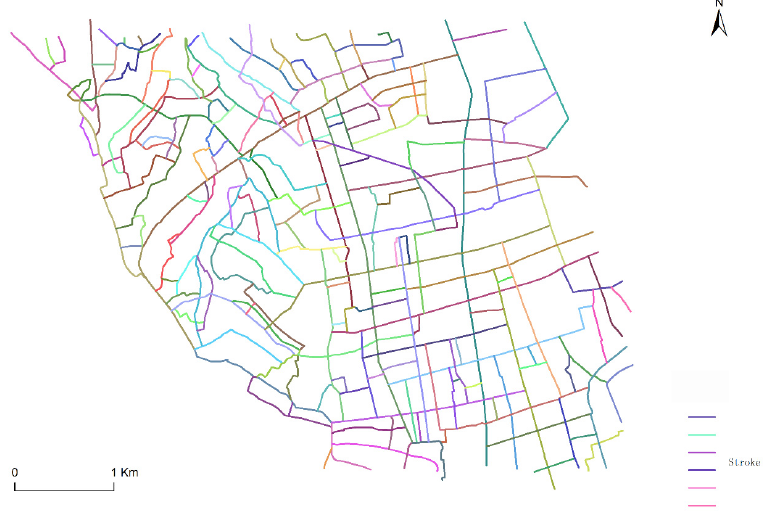
Figure 9. The results of stroke generation.